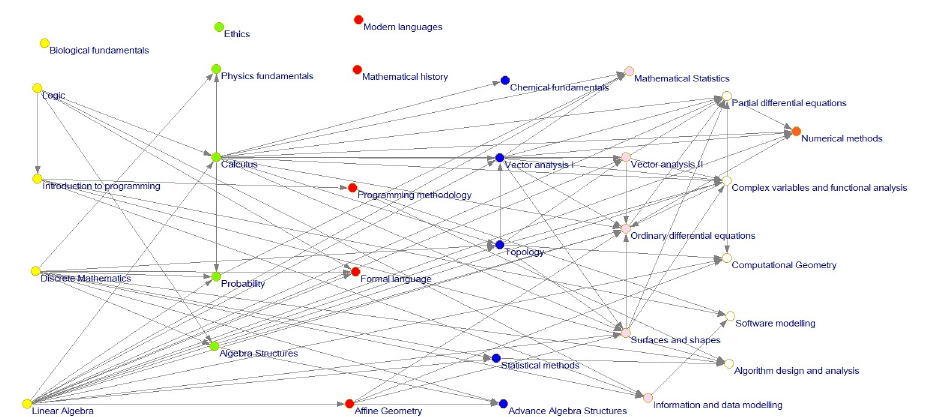
Fig 8. Level 1, 2 and 3 math curriculum network.